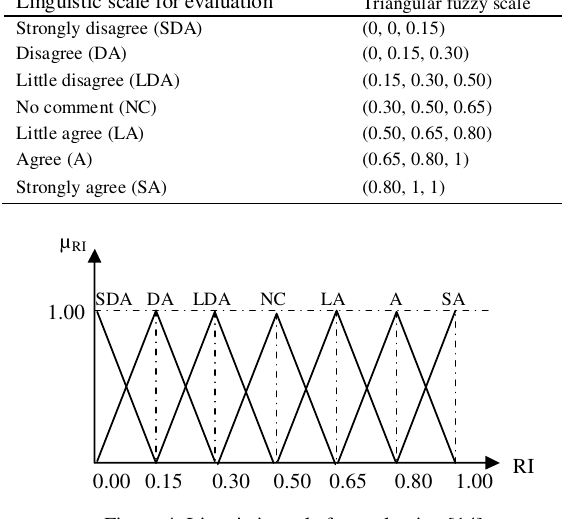
Figure 4. Linguistic scale for evaluation